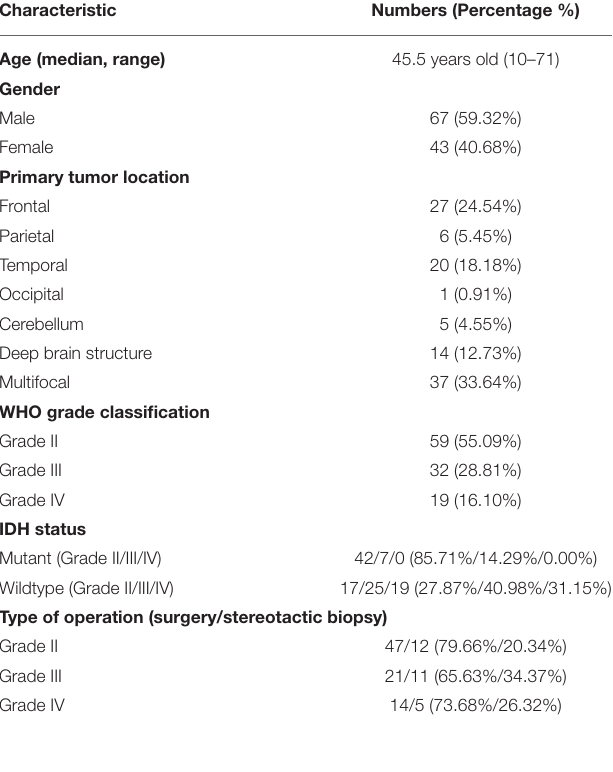
TABLE 1 | Clinicopathological features of 110 patients.